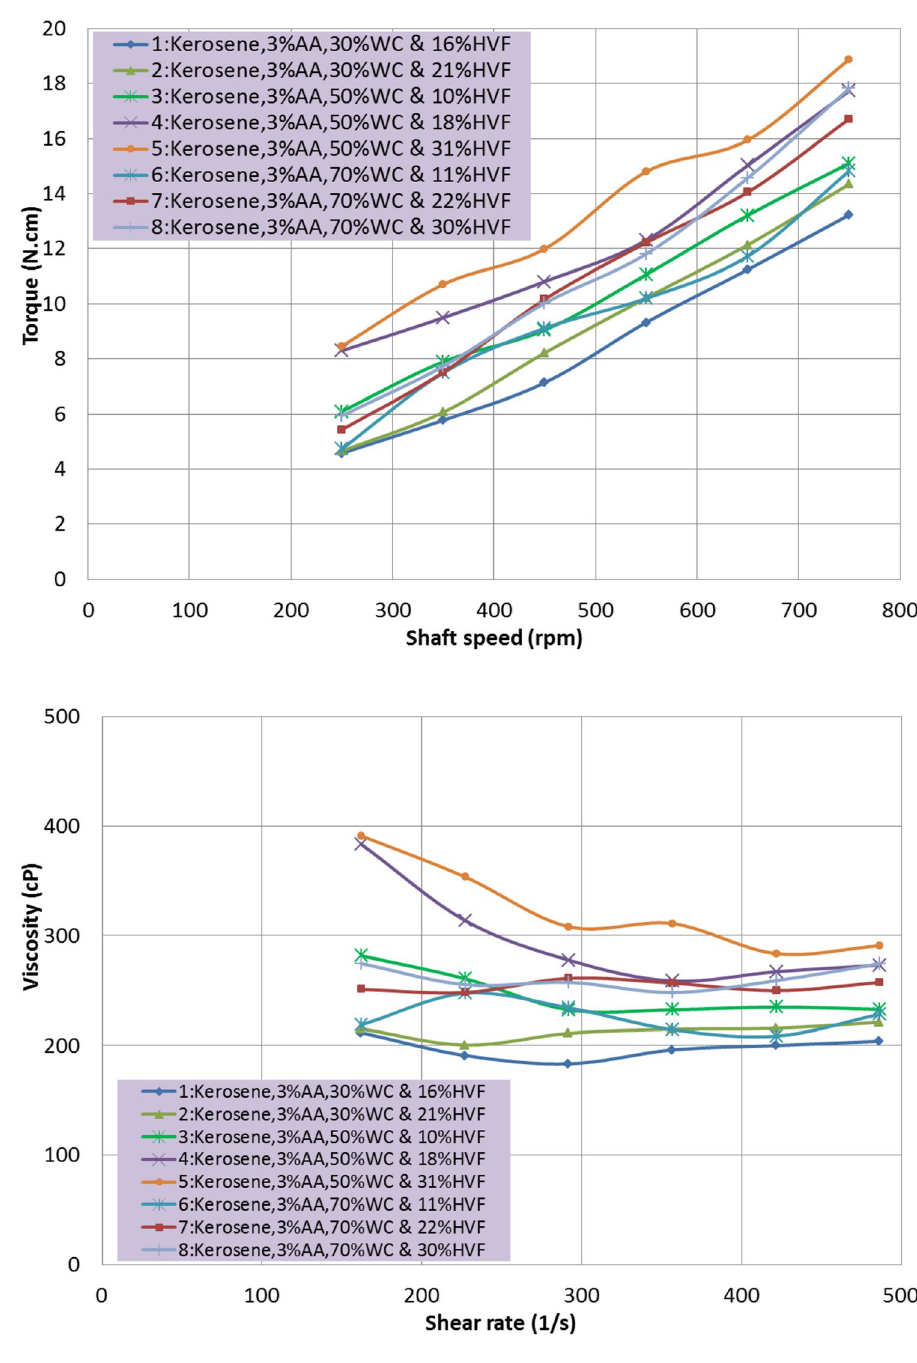
Fig. 13 Average torque values collected from Zone IV for kerosene tests. AA anti-agglo- merant, WC watercut, HVF hydrate volume fraction